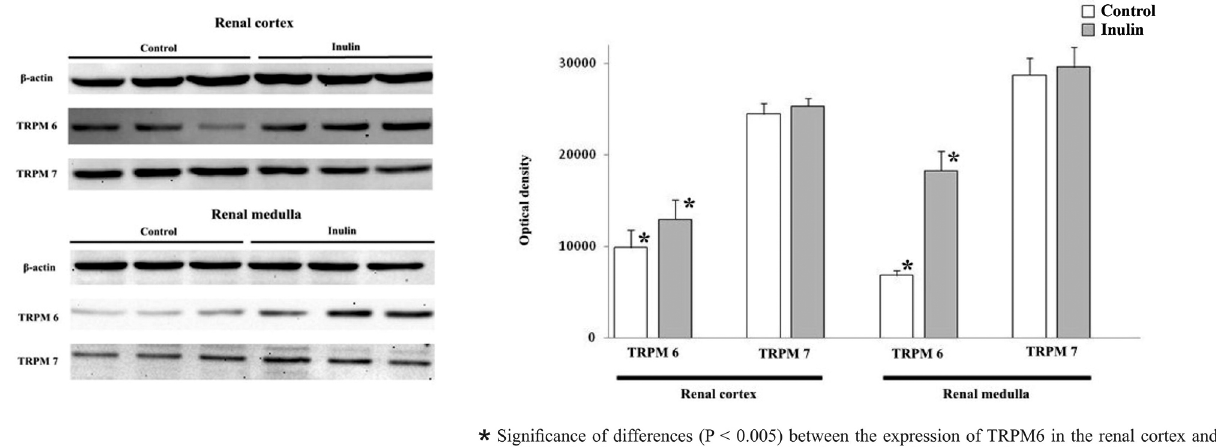
Figure 3. Representative results of immunoblotting analysis of TRPM6 and TRPM7 in the renal cortex and medulla of